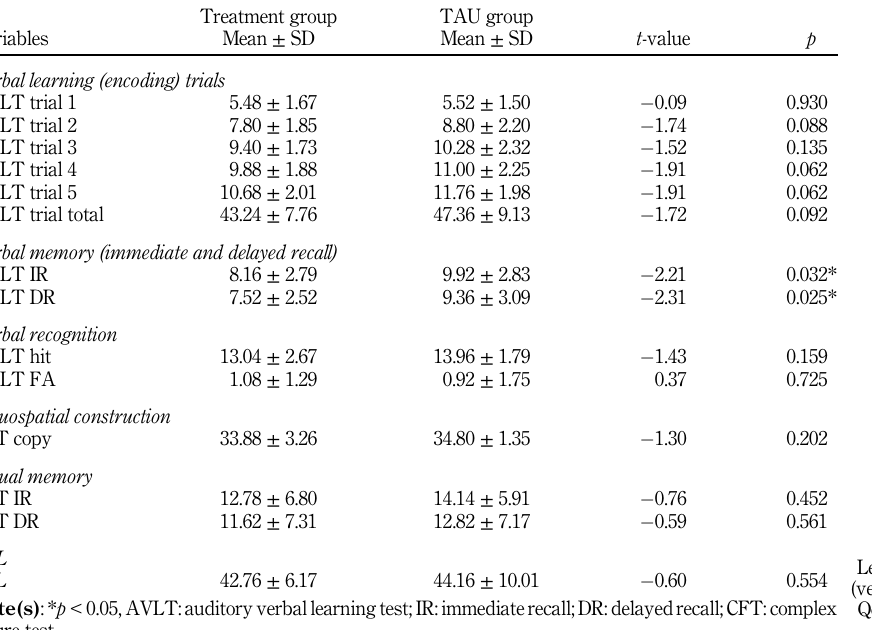
Table 1. Learning and memory (verbal and visual) and QoL in both groups at